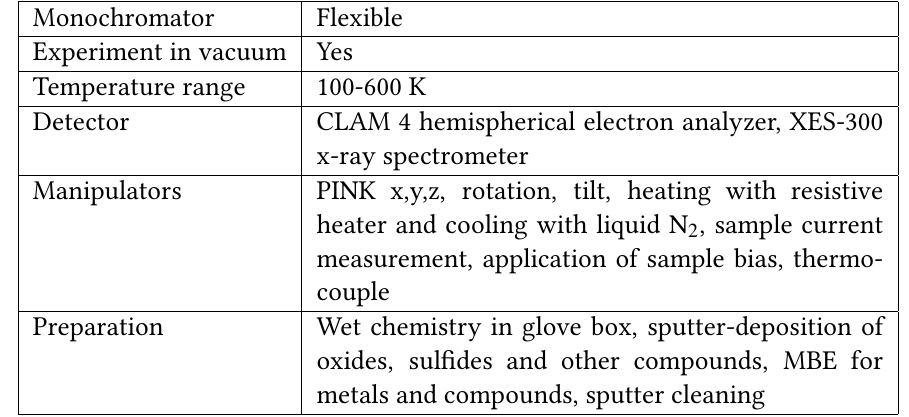
Table 1: Technical parameters for the CISSY